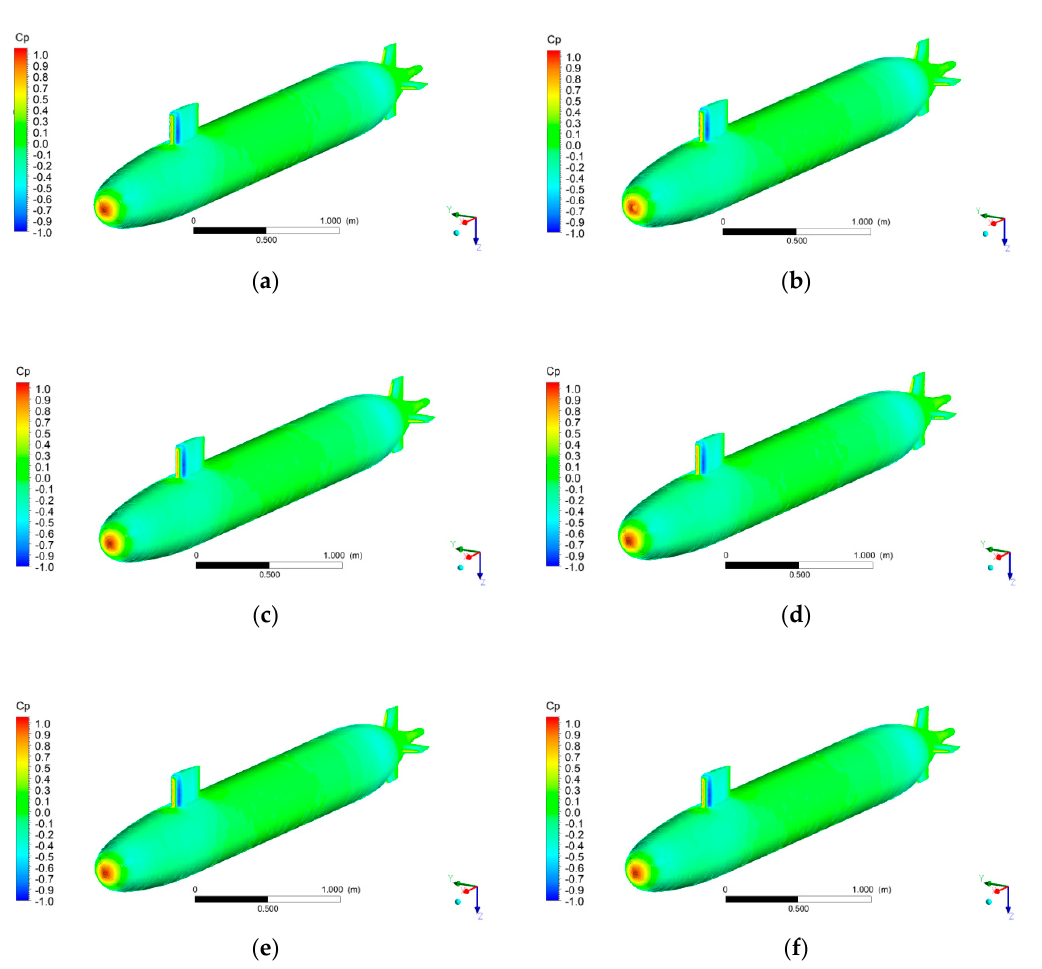
Figure 12. The distribution of pressure coefficients C p on the SUBOFF model under towing speeds of ( a ) 3.05 m/s; ( b ) 5.144 m/s; ( c ) 6.096 m/s; ( d ) 7.16 m/s; ( e ) 8.23 m/s; and ( f ) 9.151 m/s at t = 30 s.